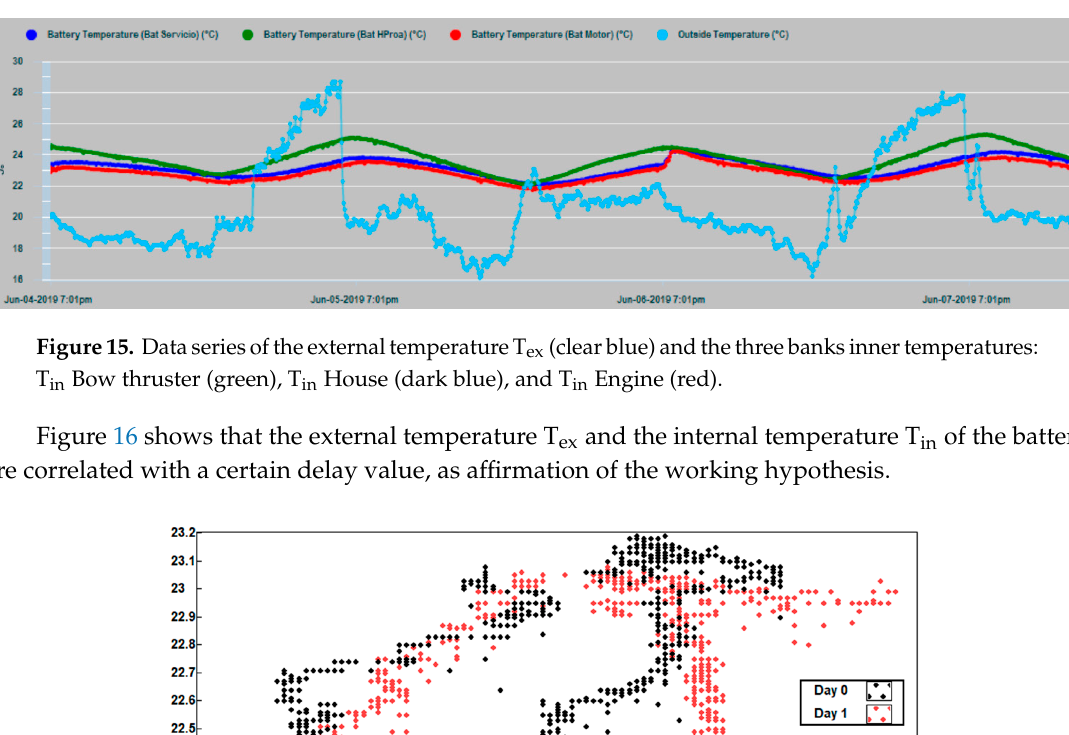
Figure 17. Time series of the T in internal temperatures of the house battery bank (red), bow thruster battery bank (blue), and engine battery bank (green). In Figure 18, a graph of the charge cycles series of the house battery bank is shown, together with the values of the charge current (positive values) and discharges by consumption (negative values). Figure 18. House battery bank charge cycling: DC current (blue), DC voltage (green). In Figure 19, a zoom of the charge and consumption cycle of the house battery bank is shown with greater clarity. Figure 19. House battery bank charge cycling zoom.